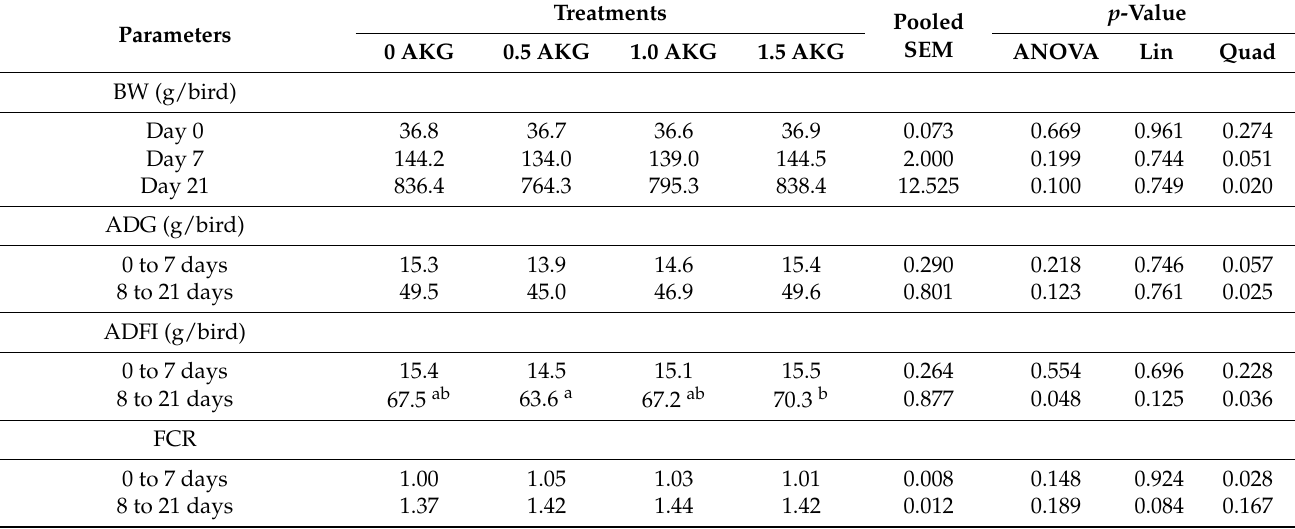
Table 4. Effects of in ovo feeding of α -ketoglutaric acid (AKG) on growth parameters of broilers from day 0 to day 21 of rearing